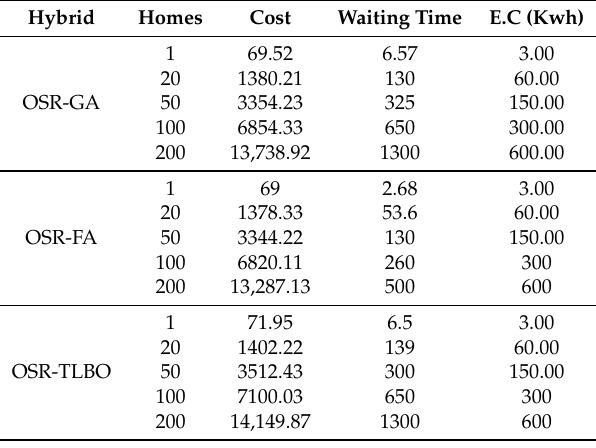
Table 9. Cloth Dryer Simulation